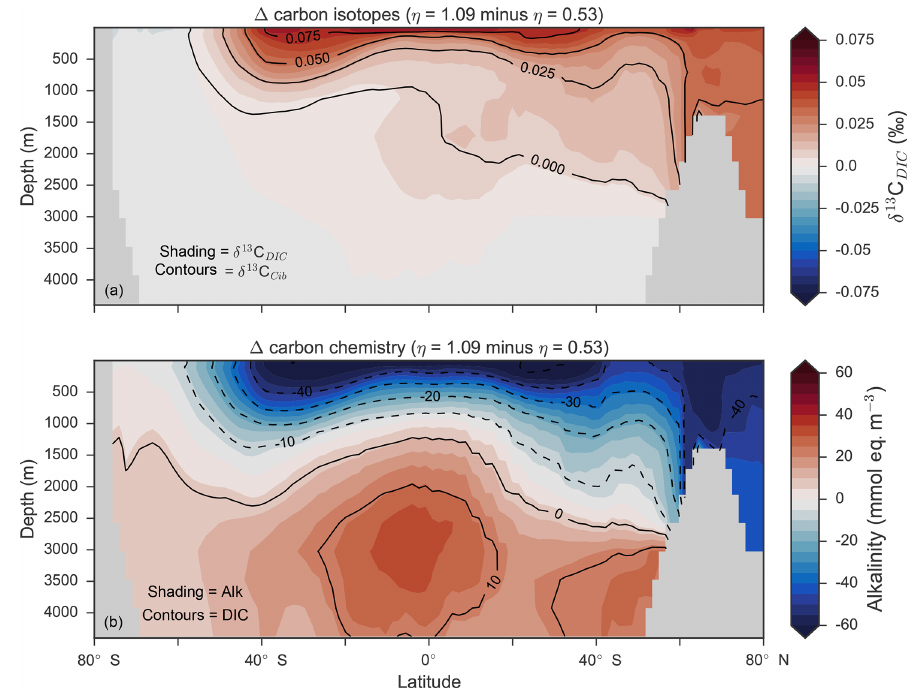
Figure 14. Changes in the distribution of carbon isotopes ( δ 13 C DIC and δ 13 C Cib ; a ) and carbon chemistry (dissolved inorganic carbon and alkalinity; b ) as a result of increasing CaCO 3 production in surface waters between 40 ◦ S and 40 ◦ N.